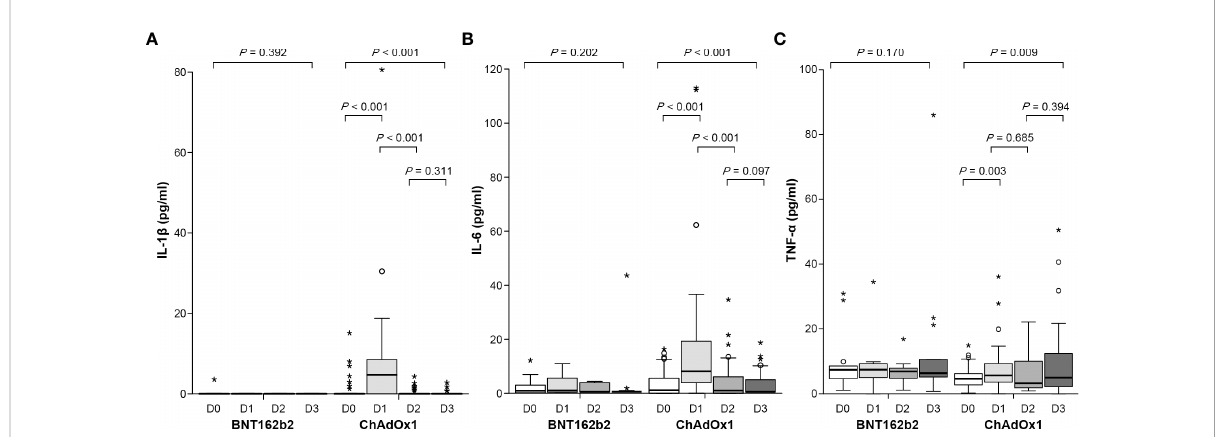
FIGURE 4 Concentration of proin fl ammatory cytokines before and after the fi rst and second dose of ChAdOx1 nCoV-19 and BNT162b2: (A) IL-1 b , (B) IL-6, and (C) TNF- a . Before the fi rst dose (D0), day 3 after the fi rst dose (D1), before the second dose (D2), and day 3 after the second dose (D3). Symbol * within graph is data value along with